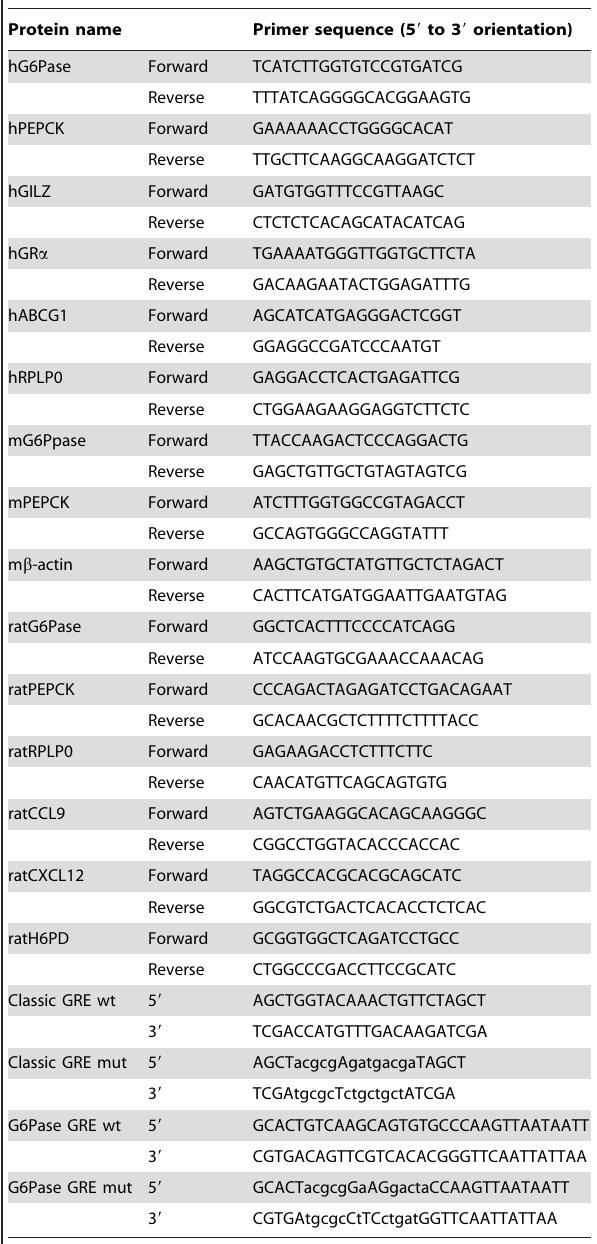
G6Pase: glucose 6 phosphatase, PEPCK: phosphoenolpyruvate carboxykinase, GILZ: glucocorticoid-inducible leucine zipper protein, GR: glucocorticoid receptor, ABCG1: ATP-binding cassette sub-family G member 1, RPLP0: acidic ribosomal phosphoprotein P0, GRE: glucocorticoid response element, h: human, m: mouse, wt: wild type, mut: mutant – letters in lower cases indicate the mutated